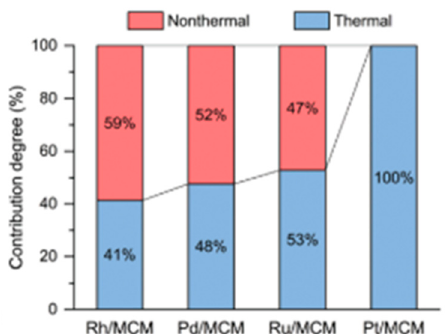
Figure 53. Contribution of thermal and nonthermal effects over various metal-loaded MCM-41’s. Reproduced from [71] with permission from The Royal Society of Chemistry.